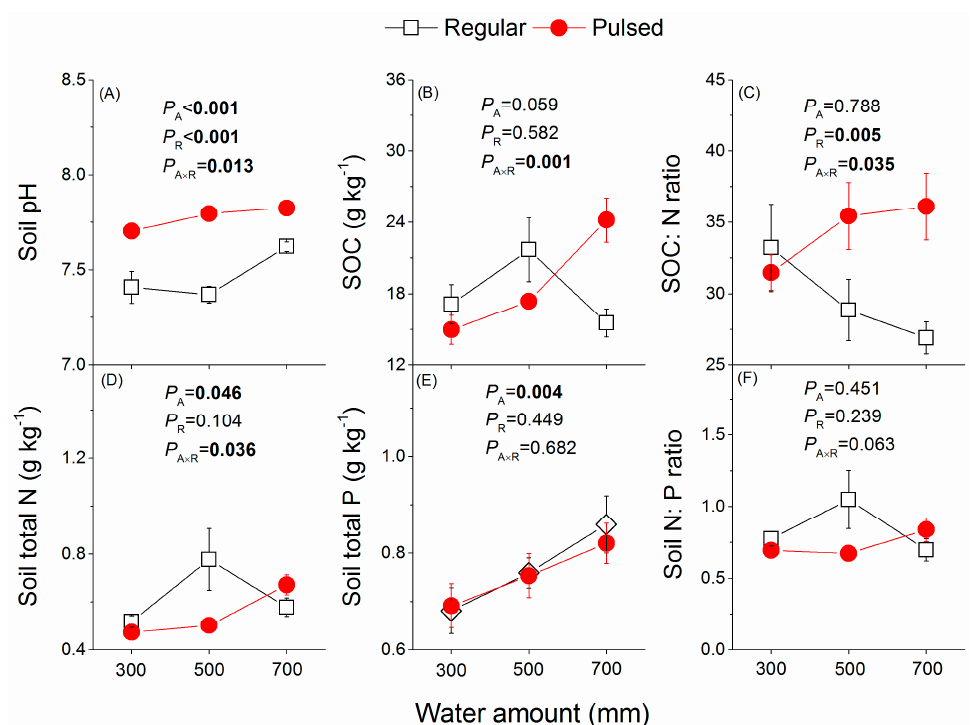
Figure 2. Effects of the watering regime (regular vs. pulsed) and water amount (300, 500, and 700 mm) on soil pH ( A ), soil organic carbon (SOC) ( B ), the ratio of SOC to soil N ( C ), soil total N ( D ), soil total P ( E ) and soil N to soil P ratio ( F ). p values of two-way ANOVAS are given. A and R represent water amount and watering regime, respectively. Plotted are means ± SE.